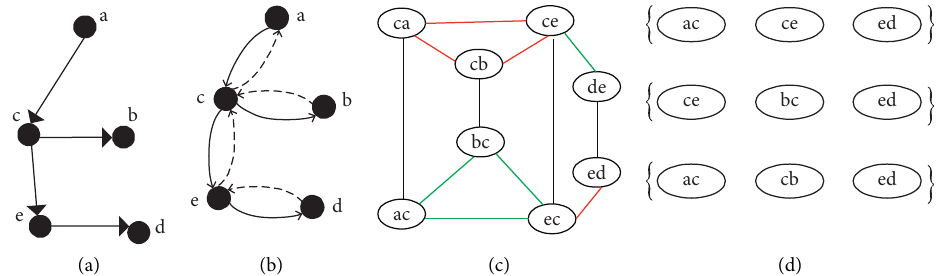
Figure 4: An example network based on the switching network. (a) An initially directed network G; (b) the symmetric directed network G'; (c) the switching network H; (d) maximum-weighted independent